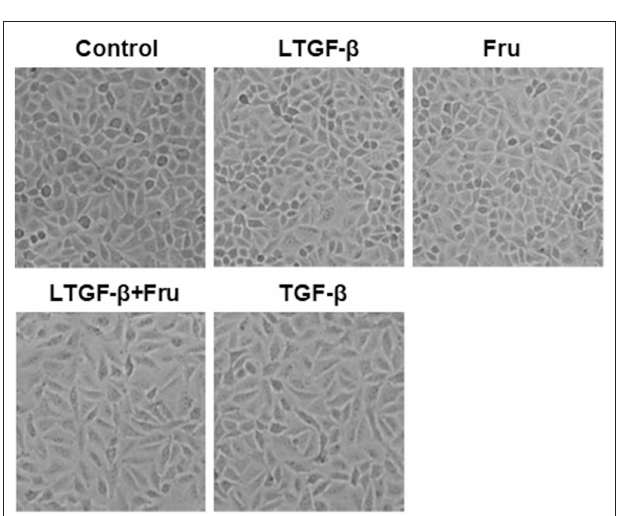
FIGURE 2 | The effect of fructose on the morphology of A549 cells treated with latent TGF- β 1. Images are representative pictures of the A549 cells treated with the indicated condition. These experiments were repeated three times. Control, 0mM fructose; Fru, 10mM fructose; LTGF- β 1, latent TGF- β